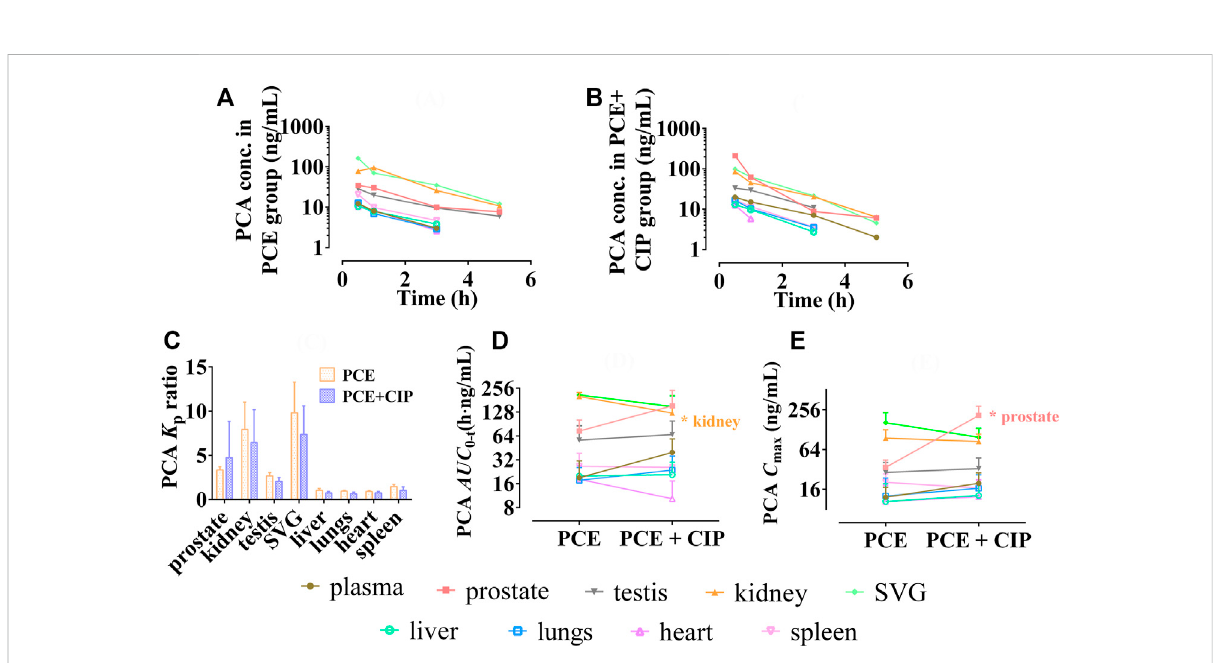
FIGURE 8 Tissue distributionpro fi les of protocatechuicacid (PCA) after oral administration ofPCE inthe absence (A) and presence (B) of cipro fl oxacin, as well as the tissue to plasma distribution coef fi cients [ K p , (C) ] and the distribution parameters AUC 0-t (D) and C max (E) of PCA (mean ± SD, n =